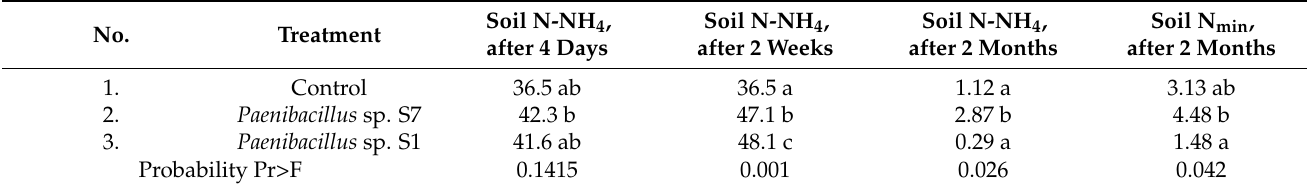
Table 4. The alteration of soil ammonium and total mineral N (mg kg − 1 ) as affected by Paenibacillus spp. strains in different time lags after microorganism application. The values marked with the same letter have no significant differences at p ≤ 0.05.